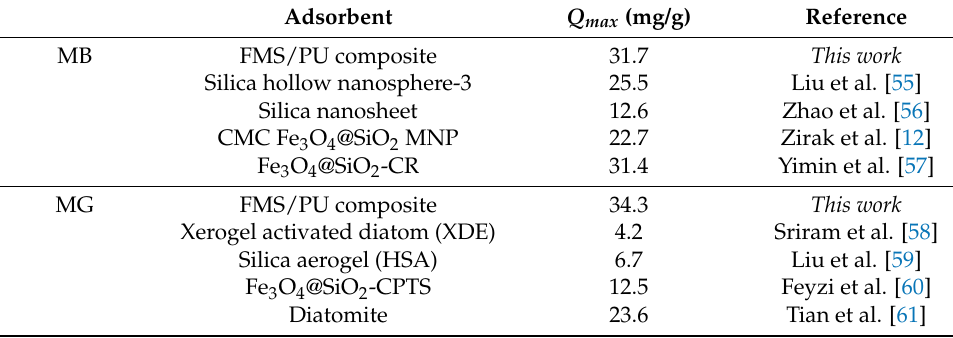
Table 4. Comparison of different silica-containing adsorbents used to remove MB and